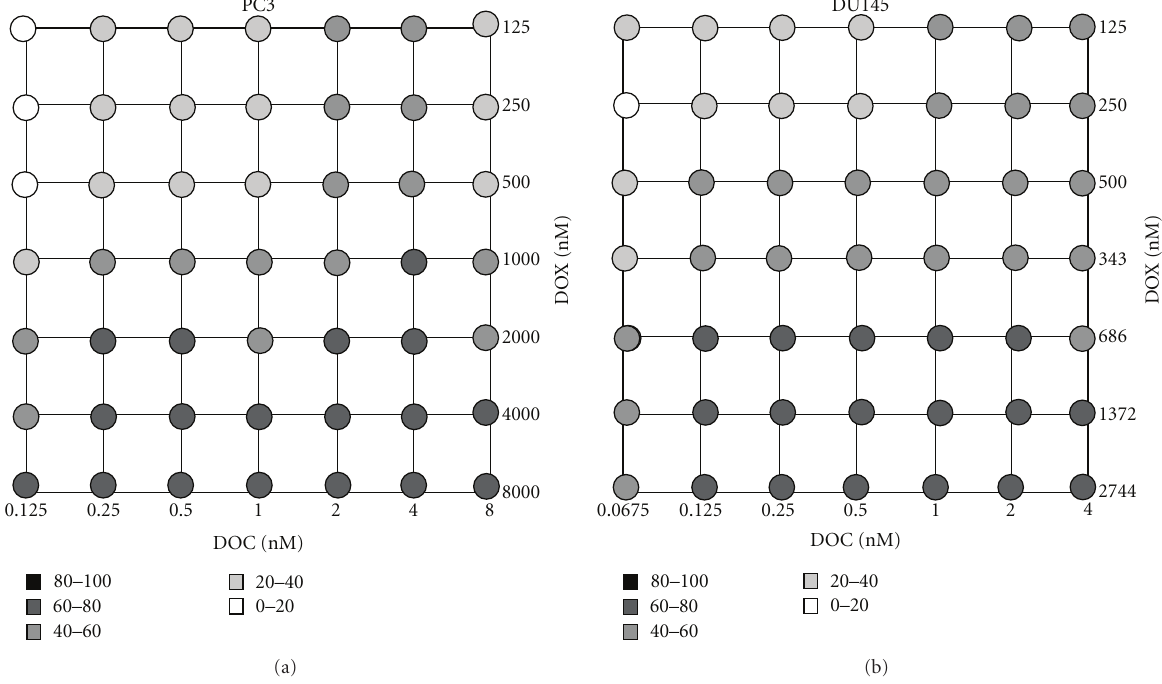
Figure 6: Focused drug combination cytotoxicity. The grayscale dots in the figure demonstrate percent cell death of PC3 and DU145 with 7 × 7 DOC/DOX combination